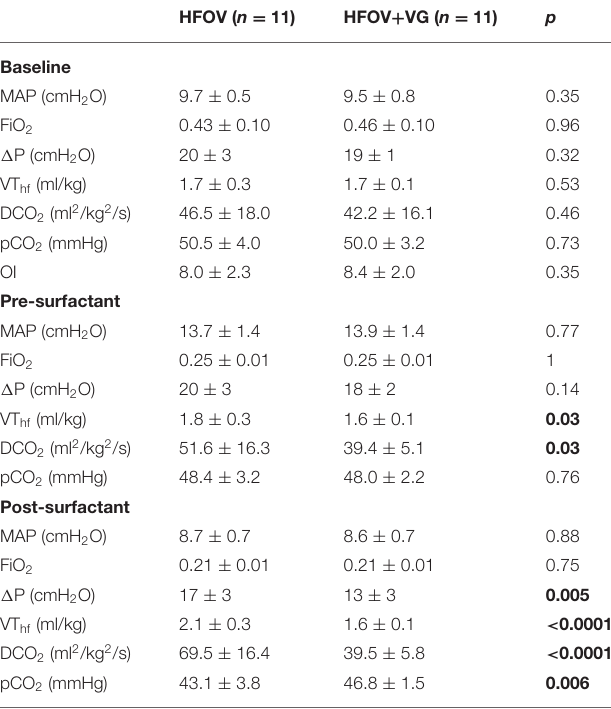
TABLE 2 | Ventilator settings, ventilation at baseline, and pre-surfactant and post surfactant